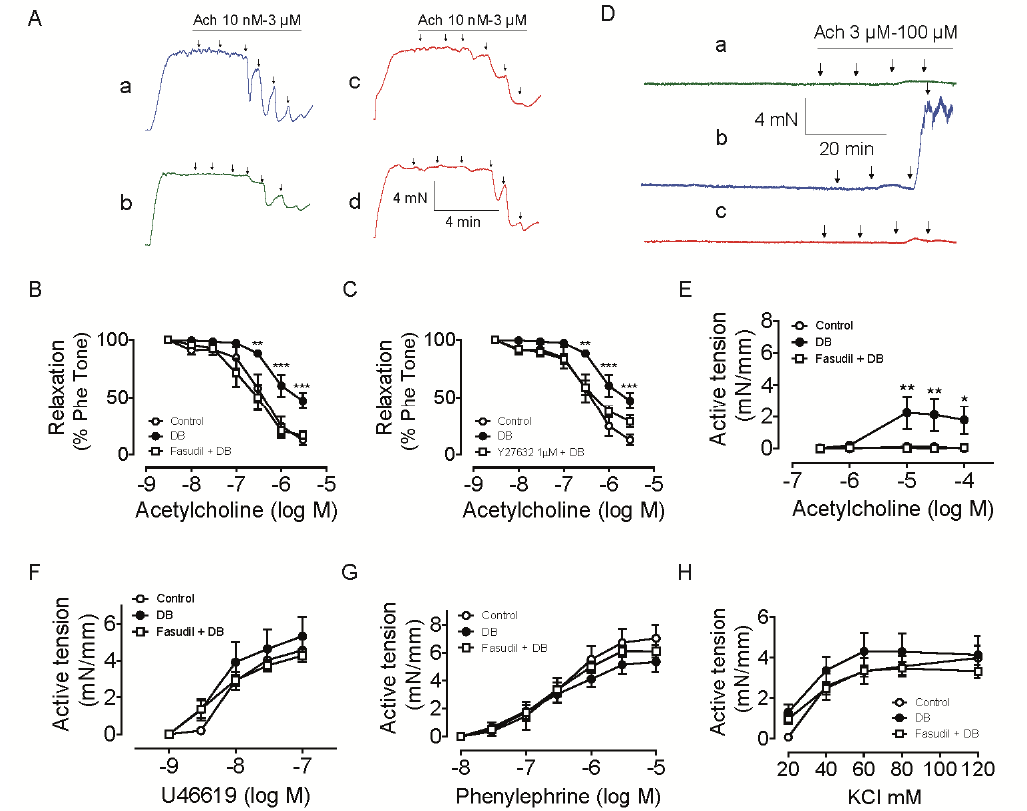
Figure 2. Effect of Rho kinase inhibition on vascular dysfunction in intrarenal artery from diabetic rats. ( A ) Representative traces showing acetylcholine (ACh)-induced relaxations in phenylephrine (Phe)-contracted artery rings from control rats ( a ); diabetic rats ( b ); diabetic rats treated with fasudil ( c ) and diabetic rats but with rings acutely incubated in 1 μ M Y27632 for 30 min ( d ); ( B ) Concentration-response curves for ACh in artery rings from rats treated with or without fasudil; ( C ) Concentration-response curves for ACh in artery rings with or without acute incubation of Y27632; ( D ) Representative traces showing acetylcholine (ACh)-induced contractions of artery rings in presence of L-NAME from control rats ( a ); diabetic rats ( b ) and diabetic rats treated with fasudil ( c ); ( E ) Concentration-response curves in artery rings for ACh with L-NAME pretreatment; ( F – H ) Concentration-response curves in artery rings in response to U46619 ( F ), phenylephrine ( G ) and KCl ( H ). * p < 0.05, ** p < 0.01, *** p < 0.001 compared with control group at respective concentration. Data are mean ± S.E.M. from four–five different